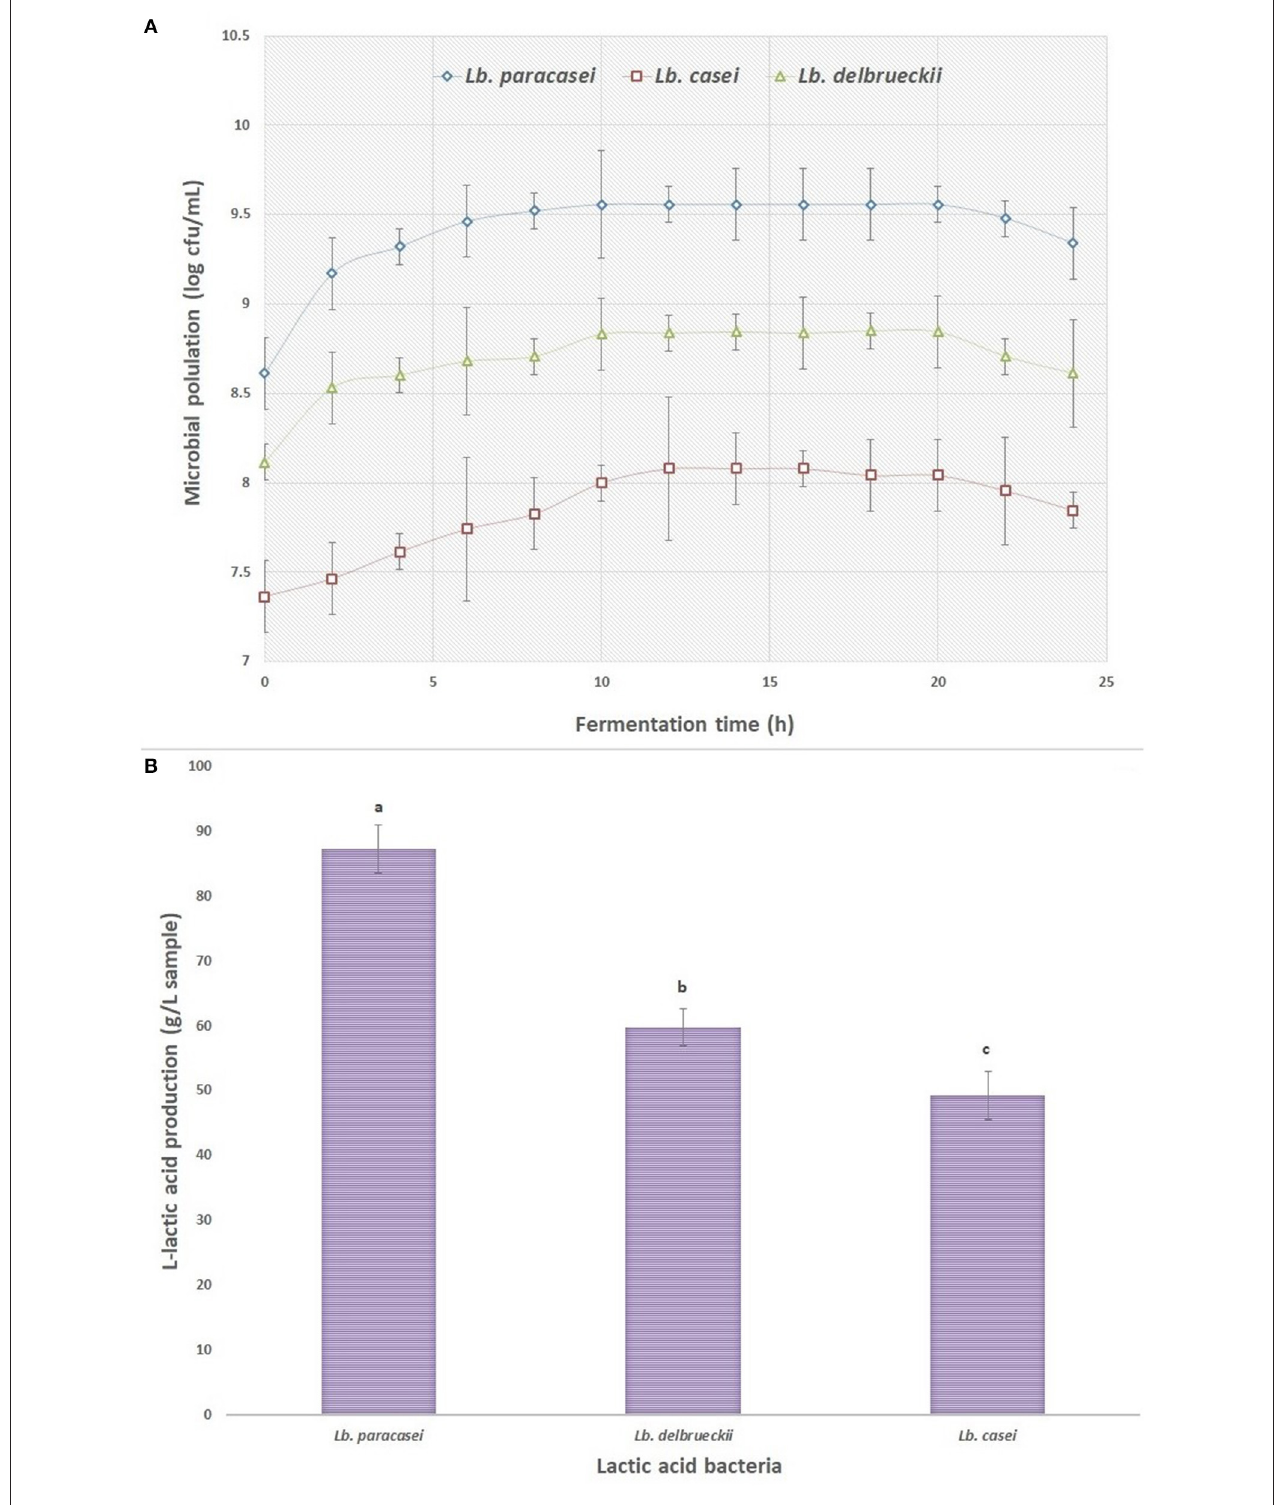
FIGURE 1 | (A) The growth curve of different lactic acid bacteria inoculated to supplemented whey (three samples were taken at each time point), and (B) the amount of L-lactic acid produced by the lactic acid bacteria at the end of fermentation process.